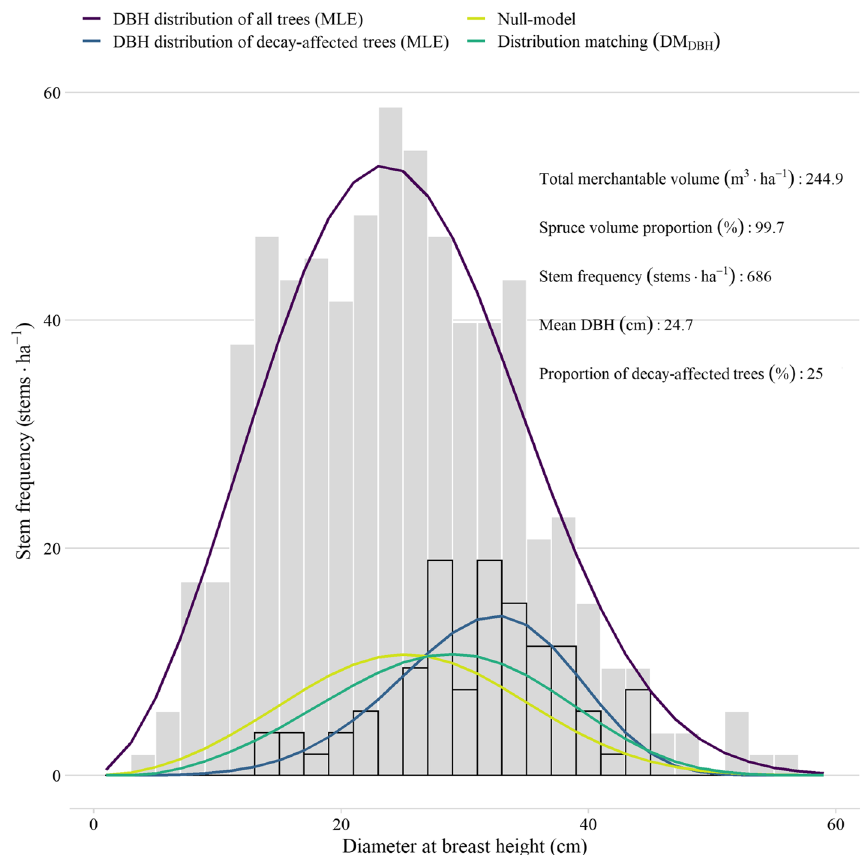
Fig. 8 Example of the harvested segment that produced a large error index ( EI diameter at breast height (DBH) distribution of decay-affected trees. The gray bars show the DBH distribution of all trees, whereas the bars with black borders refer to the DBH distribution of decay-affected trees. Note that density distributions were scaled using observed stem frequencies. MLE, maximum likelihood